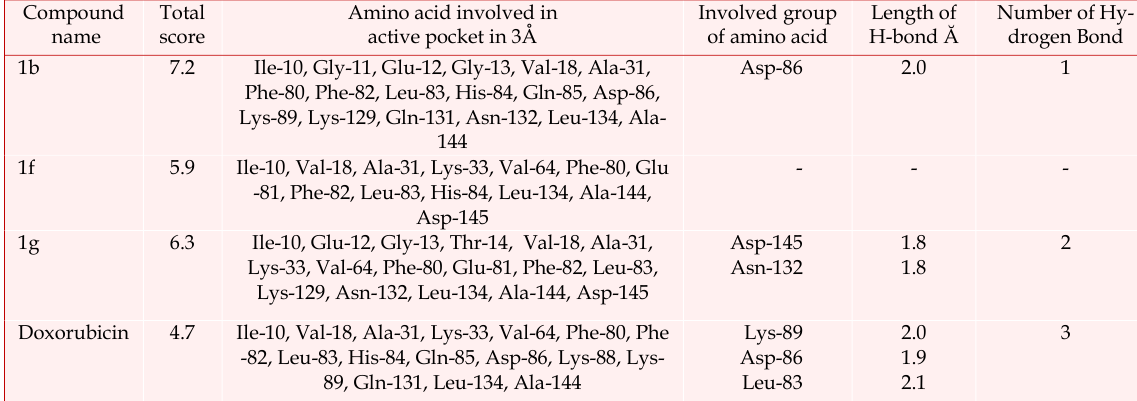
Comparison of binding affinity of standard drug (control) anti-cancer drugs and active chalcone derivative against colon cancer receptor (PDB ID:2R3J)